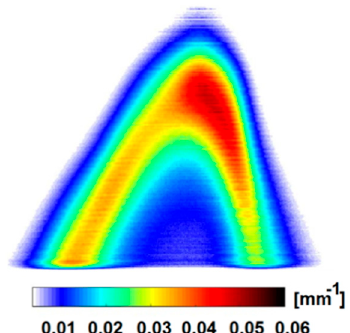
Figure 7. Image of local extinction coefficient µ e at the plane m = 30 corresponding to 15 mm inside the spray volume. In this case, µ e is in the range of 0.01 to 0.06 mm − 1 .